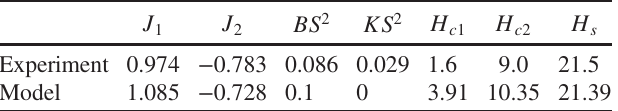
TABLE I. Exchange parameters (K) and critical fields (T), S ¼ 7 = 2 . Experiment: experimental values of the fields defining parameters of the model as described in the text. Model: chosen parameters of the model (1) with the resultant critical